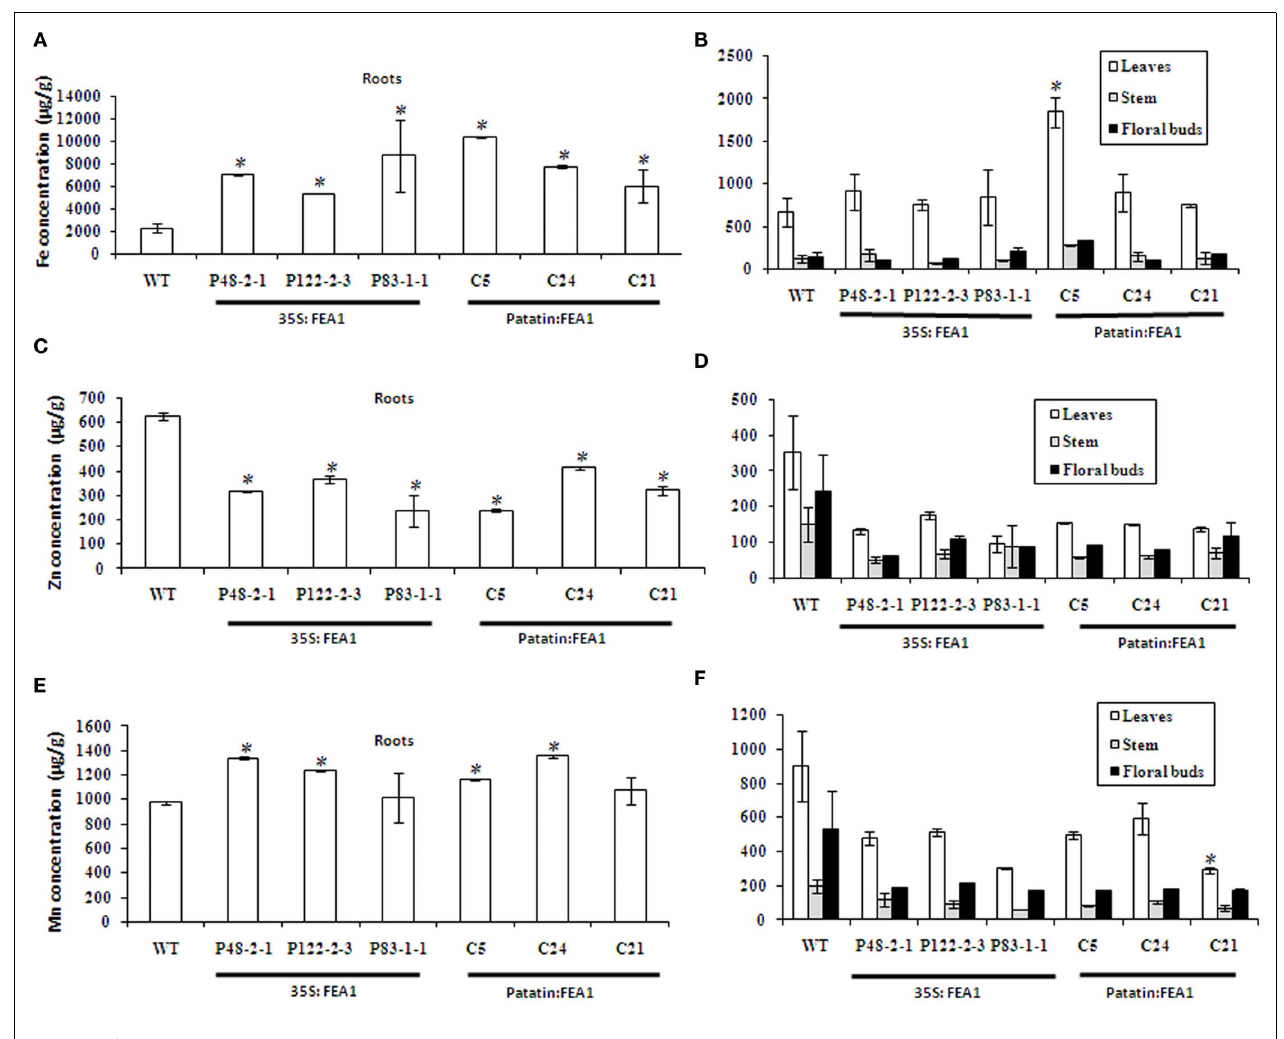
FIGURE 6 | FEA1 specifically increases root iron levels in transgenic plants. (A) Iron levels in roots; (B) Iron levels in leaves, stems, and floral buds; (C) Zinc levels in roots; (D) Zinc levels in leaves, stems, and floral buds; (E) Manganese levels in roots; (F) Manganese levels in leaves,